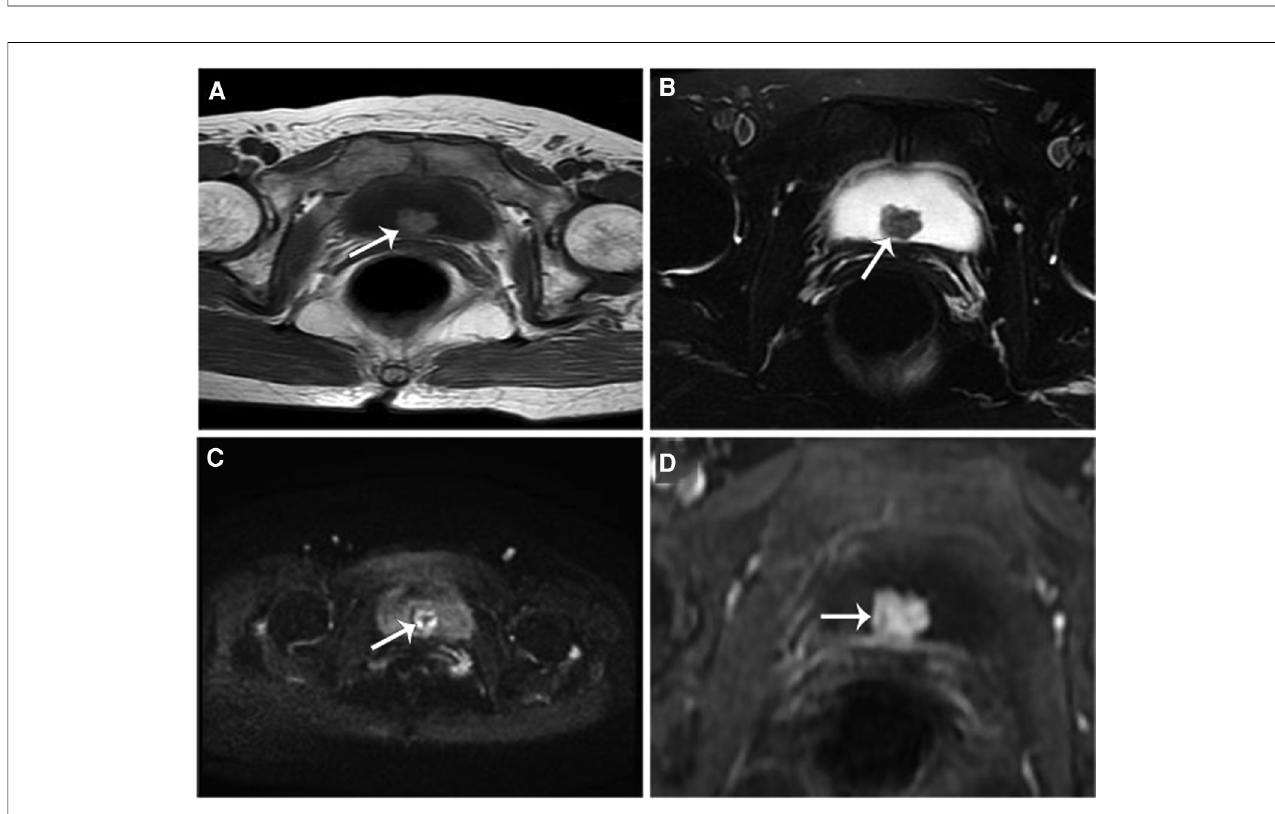
FIGURE 2 T1wt1 image ( A ) and STIR images ( B ) showed cauli fl ower-like soft tissue signal nodular shadow (white arrow) in the posterior bladder wall, which was isosignal compared with that of the muscle. It had a wide basal connection with the bladder wall. High signal nodular shadow on DWI ( C ), with signi fi cant inhomogeneous enhancement on enhancement scan ( D